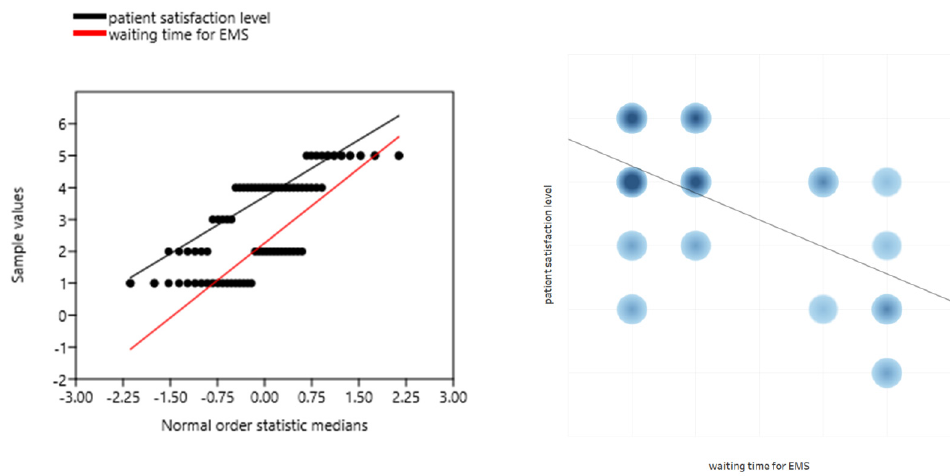
Figure 5. Correlation of the level of patient satisfaction with the waiting time for EMSs.